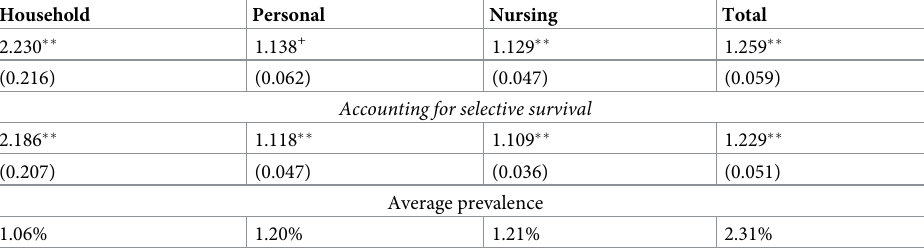
Fig 3. Mortality by home care use in each year.